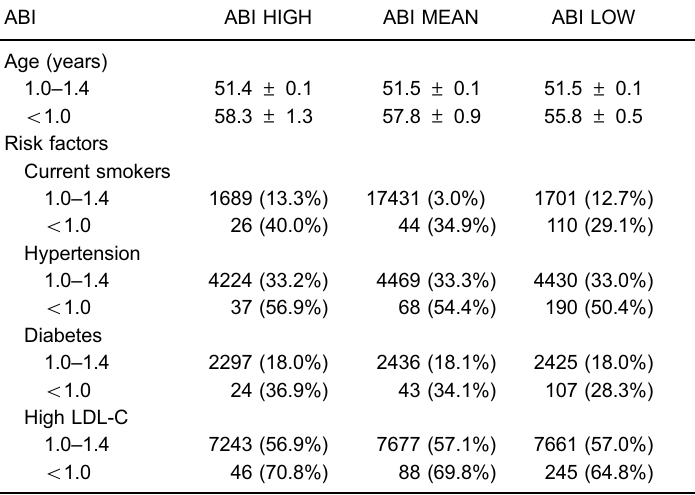
Table 2. Age and prevalence of cardiovascular risk factors according to the three categories of ankle-brachial index (ABI) obtained with different methods of calculation at the baseline of the ELSA-Brasil study (2008 – 2010).